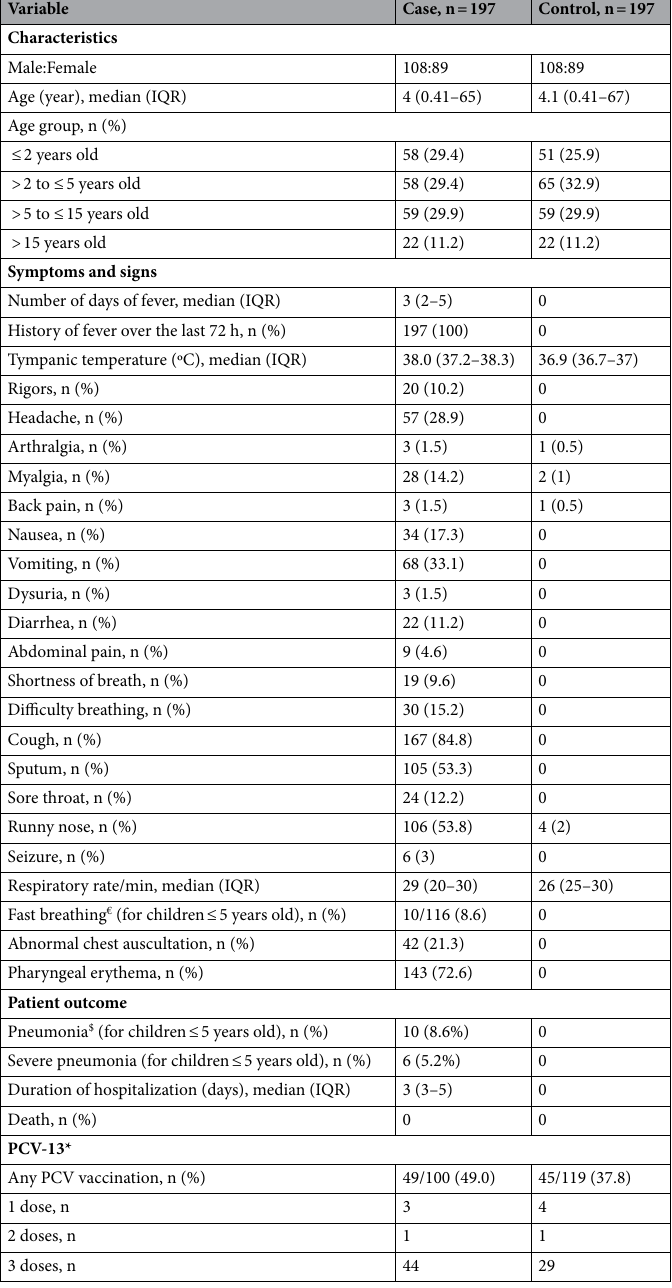
Table 1. Participant characteristics and their clinical signs and symptoms. € Fast breathing = aged 2–11 months: ≥ 50 breaths/min, aged 1–5 years: ≥ 40 breaths/min. $ Pneumonia and severe pneumonia were defined according to WHO criteria 19 . Children who presented with cough or difficulty breathing and had fast breathing or chest indrawing, were classified as having pneumonia. Children who presented with cough or difficulty breathing and had at least one of the following criteria were classified as severe pneumonia: oxygen saturation < 90%, while breathing room air, or central cyanosis; severe respiratory distress; signs of pneumonia with a general danger sign (inability to breastfeed or drink, lethargy or reduced level of consciousness, convulsions, vomiting). *The number of doses were recorded if the vaccination card was seen by the study team. The pneumococcal conjugate vaccine 13 (PCV) was included in the Expanded Program on Immunization in Laos about 5 years before this study was